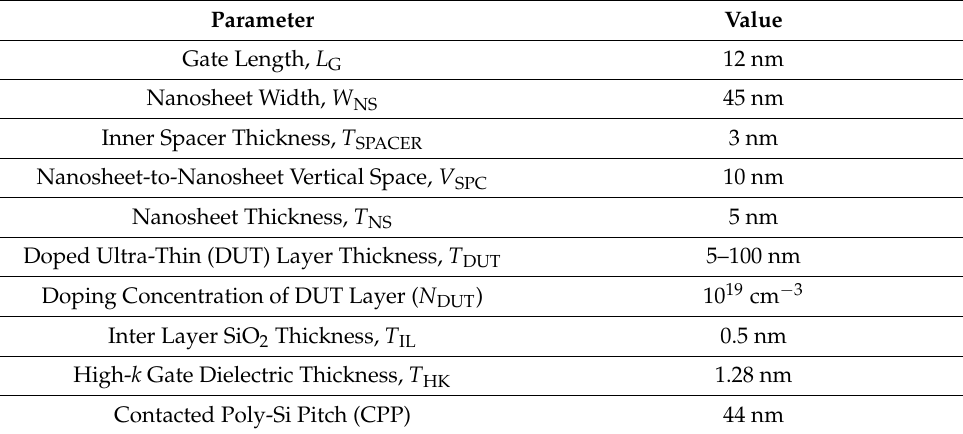
Figure 2. ( a ) Simulated NS FET device structure including the epitaxially–grown DUT layer on the starting wafer. Cross–sectional view of the proposed NS FET with a cut along the ( b ) gate and ( c ) channel directions, respectively. Table 1. Dimensions and parameters used for the TCAD simulations.